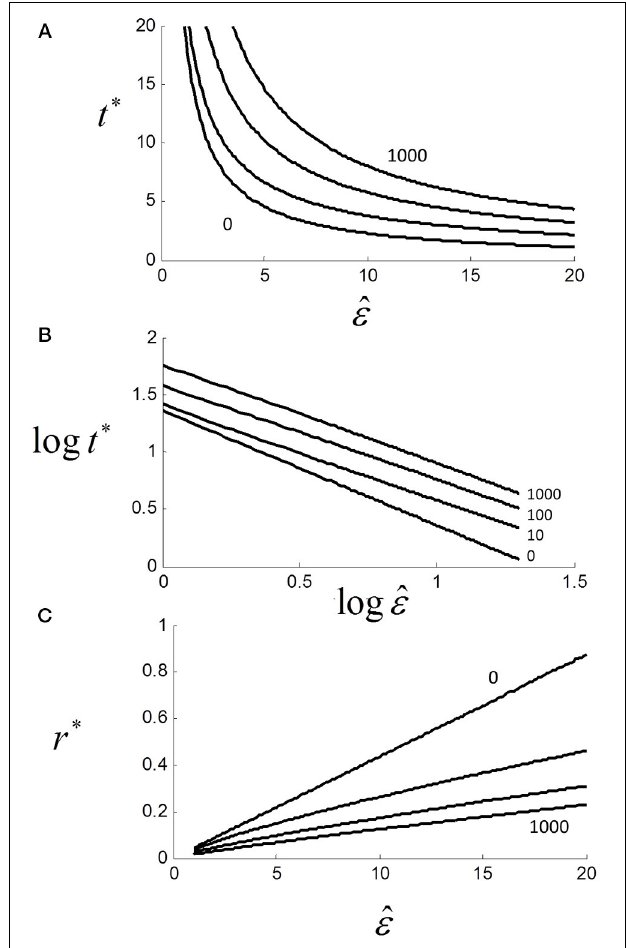
FIGURE 12 | (A) Effect of scaling factor ˆ ε on optimal decision time t ∗ for different non-decision time T ND = { 0 , 10 , 100 , 1000 } (see text). Note that t ∗ and hence RT increases with T ND , although asymptote is zero (not shown); (B) same as (A) but on log-log axes (base 10) showing near power function t ∗ ≈ a ε − k with k = { 0 , 0 . 82 , 0 . 83 , 0 . 87 } and a = { 25 . 1 , 25 . 1 , 39 . 8 , 63 . 1 } from linear regressions; (C) linear plot of optimal rate r ∗ vs. ˆ ε . Although strictly a power function, relationship is locally quasi-linear.